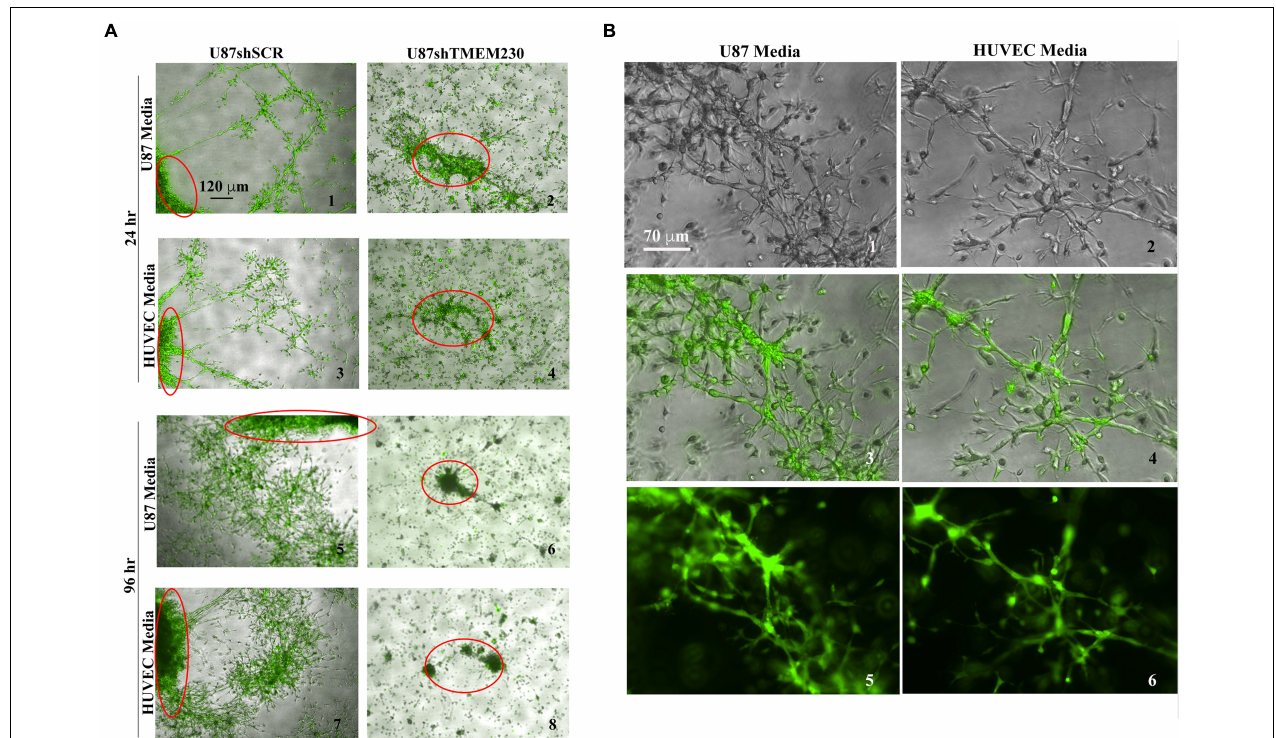
FIGURE 7 | Endogenous expression of TMEM230 promoted U87-MG migration and tubule like structure formation recapitulating a vascular mimicry like behavior. (A) Representative 3D bodies or structures (only the borders of a larger 3D body of U87shSCR or a complete body of U87shTMEM230 cells are shown by red circles) of U87 cells expressing endogenous TMEM230 displayed vascular mimicry, cell sprouting, collective cell movement, and invasion in 3D Matrigel. U87 cells in which endogenous TMEM230 was downregulated did not generate 3D bodies of significant size in agreement that TMEM230 was required for U87 cell growth. Two different media were used for generating VM like structures from U87 cells, media used for culturing adherent U87 tumor cells or HUVEC shown in Figures 3 , 5 (top panel), respectively. (B) Higher magnification of control